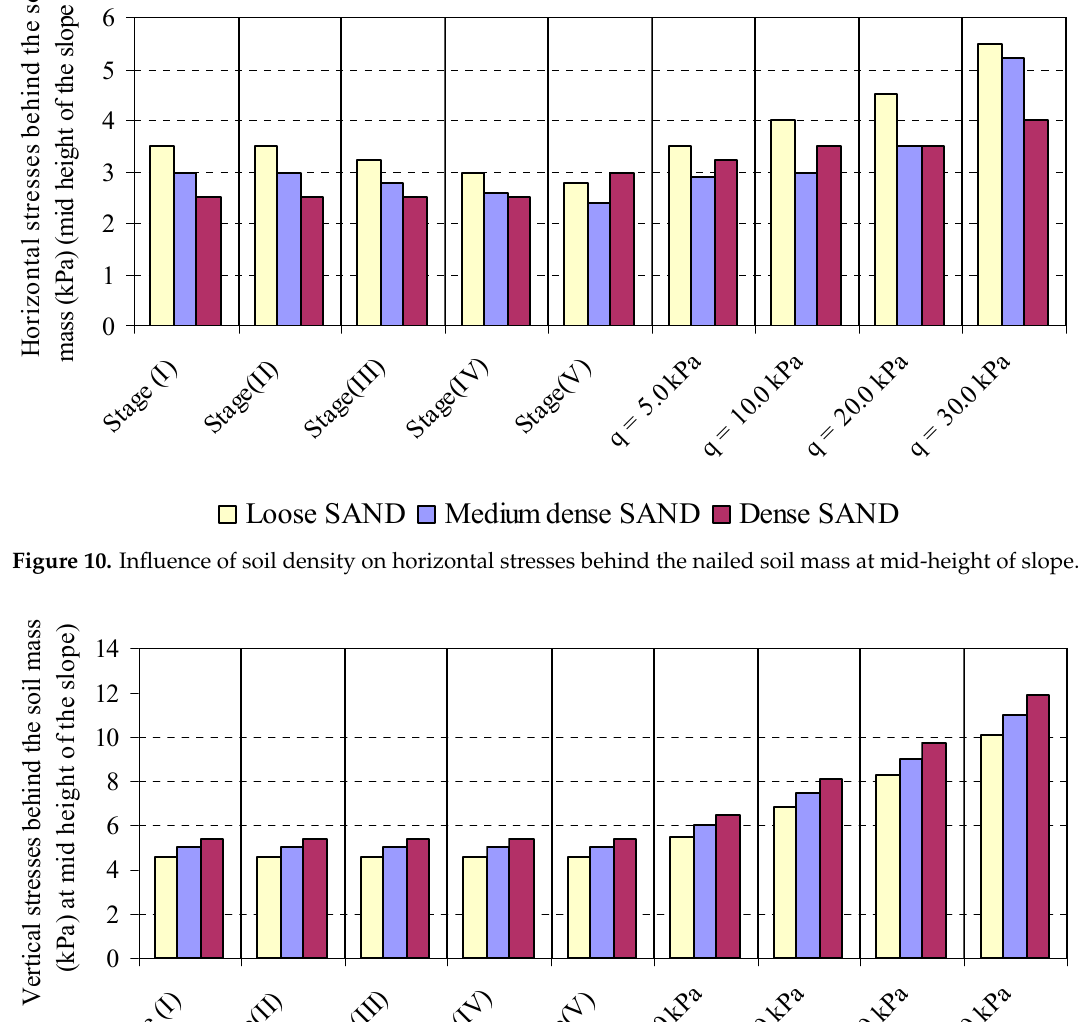
Figure 9. Influence of soil density on the slope face horizontal stresses at mid-height.